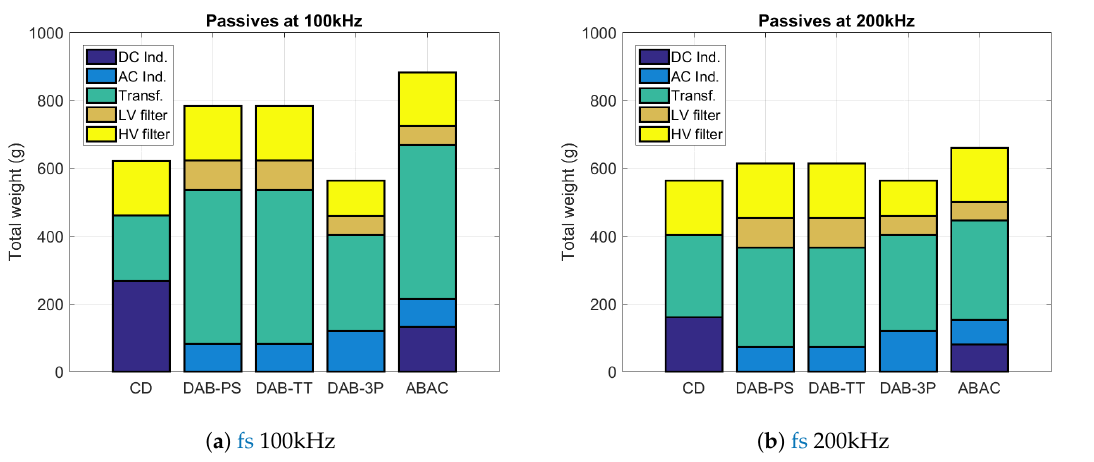
Figure 12. Topologies passives weight